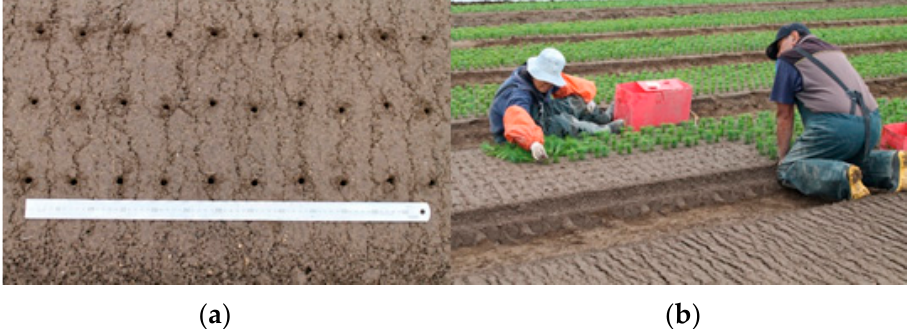
Figure 17. Outcomes of the dibbler field test. ( a ) Holes dibbled by the dibbler. ( b ) Inserting the cuttings into the holes.